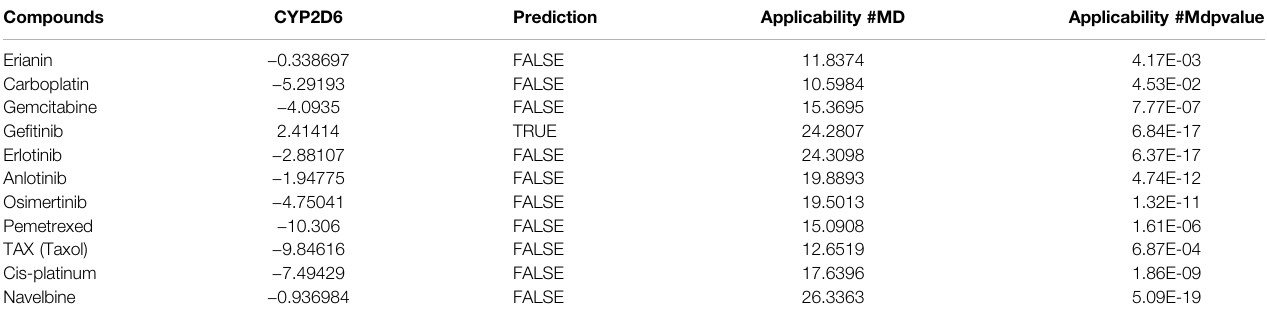
TABLE 4 | Cytochrome P450 2D6 inhibitor prediction of erianin and reference drugs.